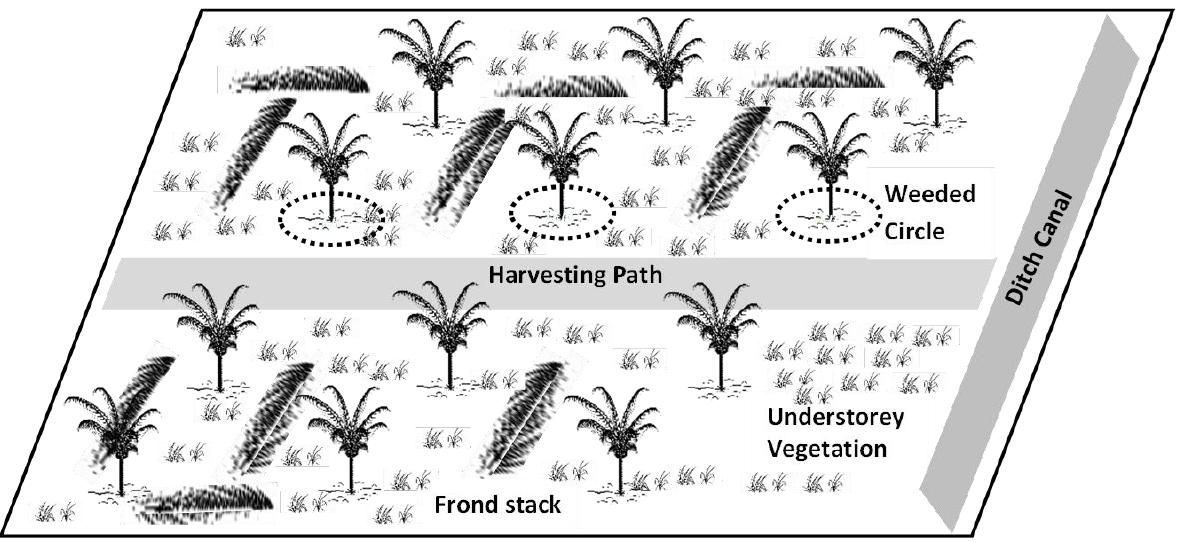
Figure 2. Sampling plot